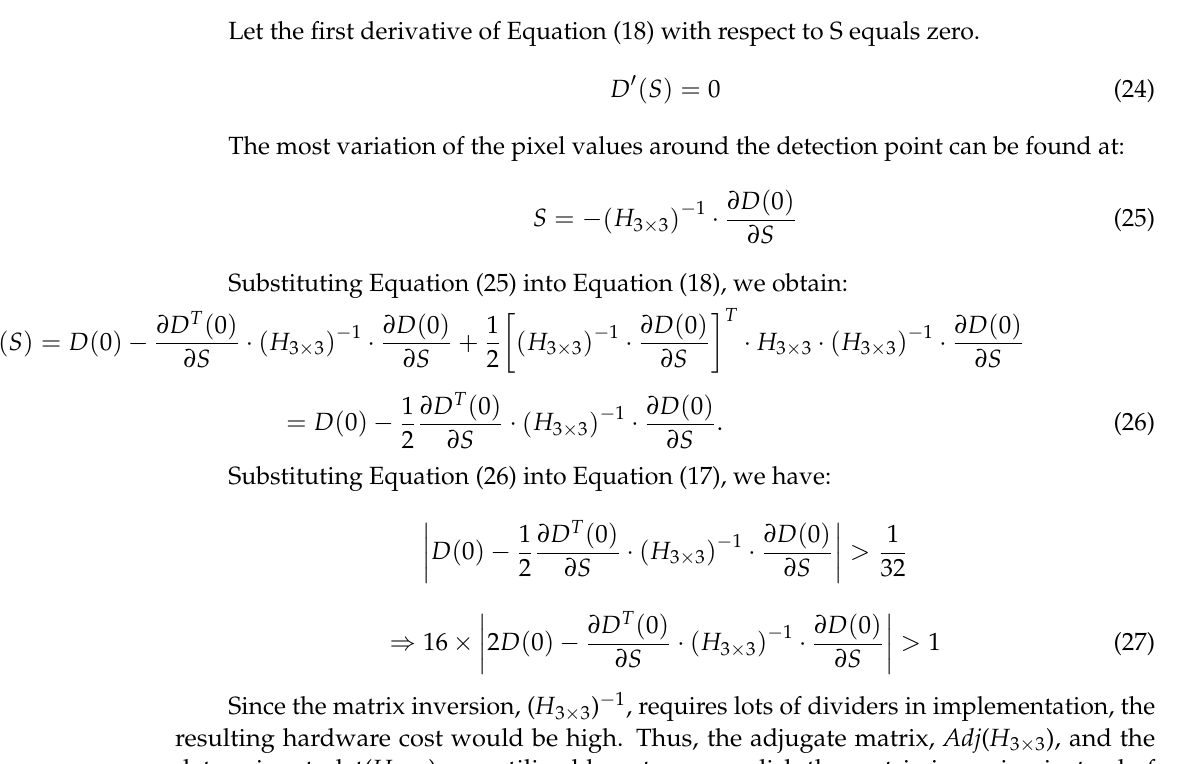
Figure 13. Hardware architecture of partial derivative of D (0).